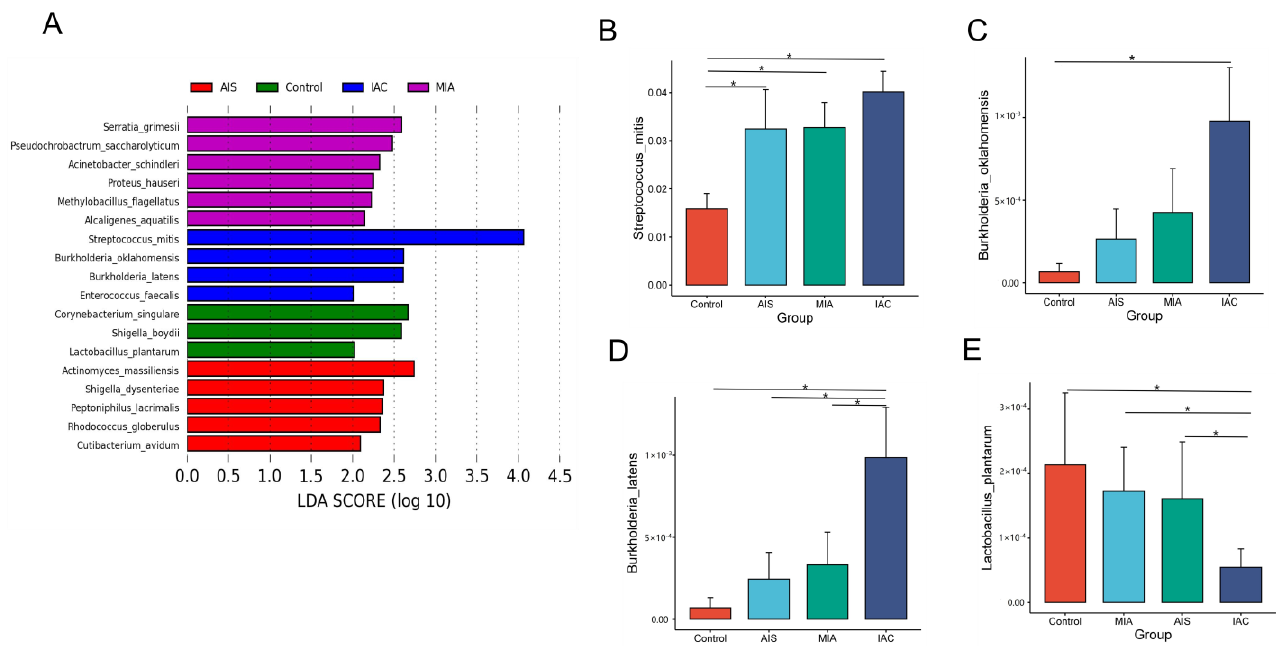
Figure 5. ( A ) Differentially abundant microbiota among four groups based on varying histopathology identified by LEFSE; ( B – E ) bar chart showing significant differences in abundance at the species level. The Wilcoxon rank-sum test was used as a statistical test, and “*” indicates a significant difference between two groups ( p < 0.05).